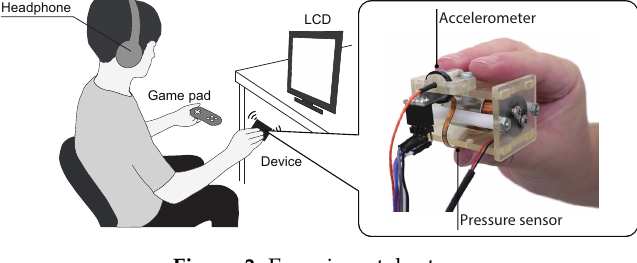
Figure 3. Experimental